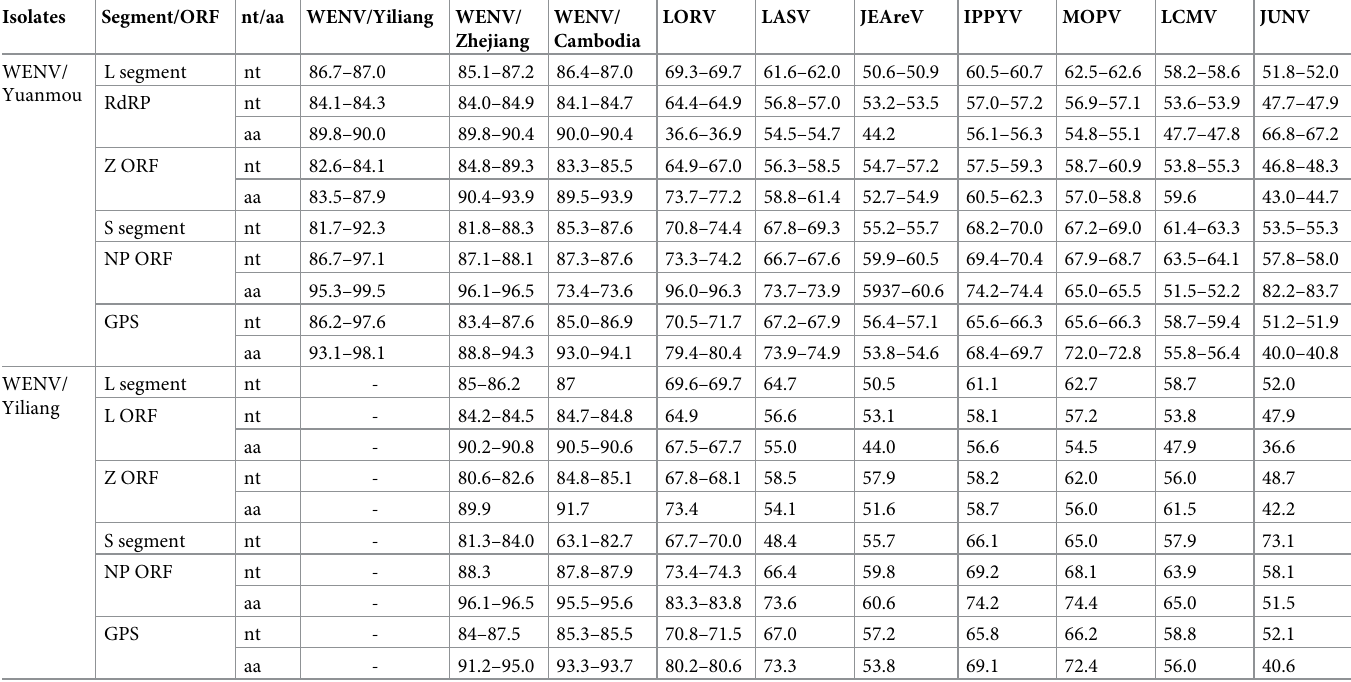
Table 2. Genome or ORF comparisons between various viriants of We¯nzh ō u virus and other